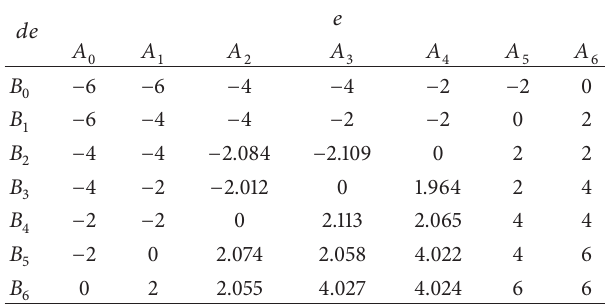
Table 2: The controller parameters. Table 3: Rule table after adjustment of neuron fuzzy